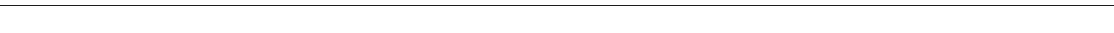
Fig. 6 hQTLs alter eQTL gene expression within chromatin networks. Quadrant plots for statistically signi fi cant interactions with genes within the HLA region ( a ) and outside the HLA region ( b ). Each statistically signi fi cant (FDR < 0.05%) distal interaction is represented by a point oriented by the value